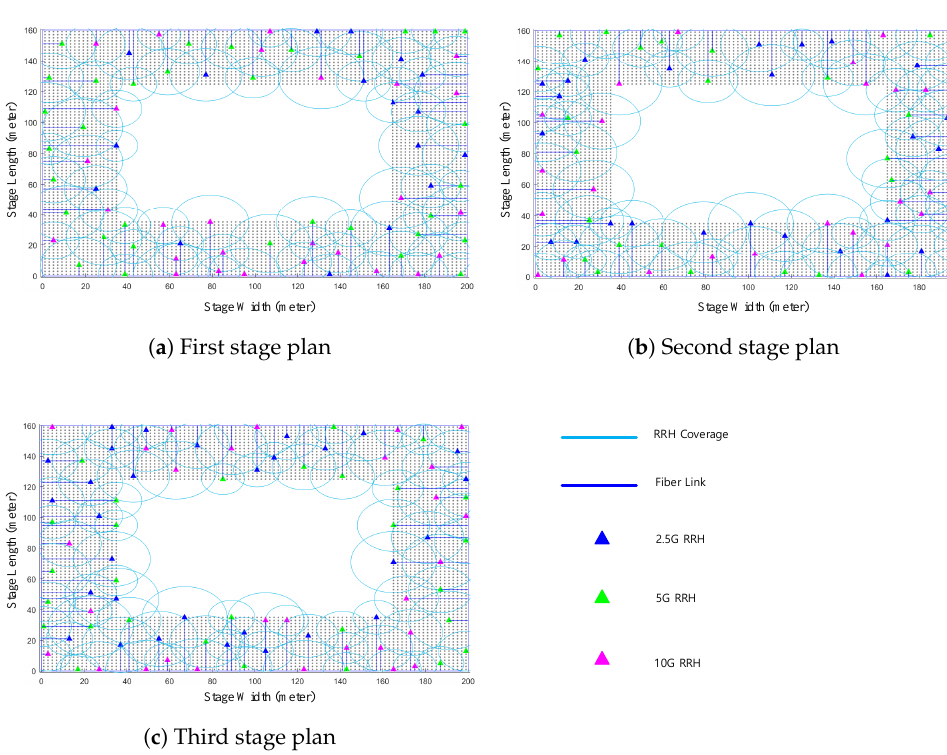
Figure 5. Illustrative example of RRHs’ random distribution for the stadium